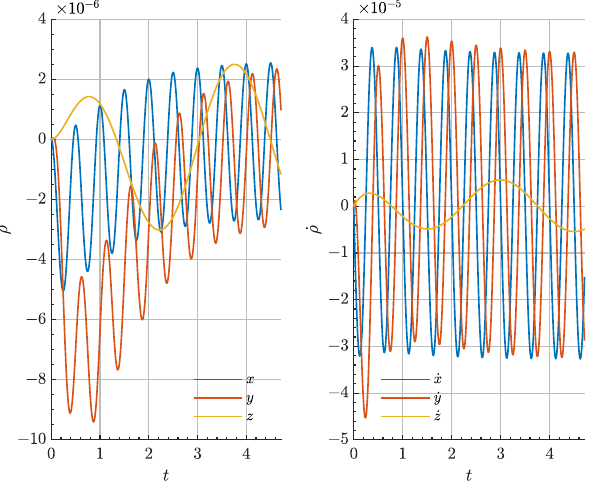
Figure 24. Relative state evolution for the Lunar Gateway resupply mission during formation flying.